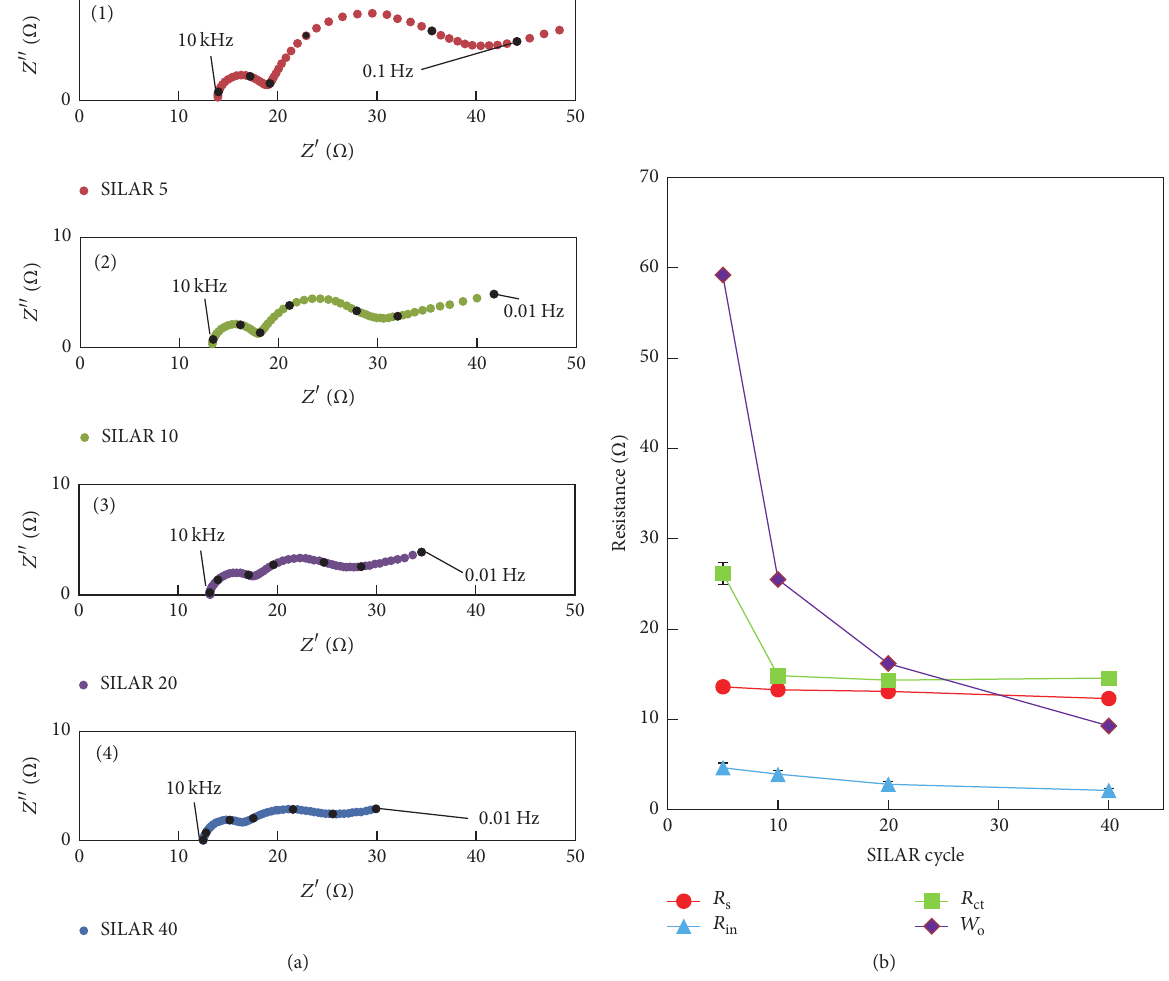
Figure 4: Nyquist plots of porous-FTO (5 𝜇 m)/CuS electrodes for various SILAR cycles. Panels (a)(1), (a)(2), (a)(3), and (a)(4) are the results for SILAR cycles with 5, 10, 20, and 40 times, respectively. SILAR cycles dependence on the resistance is shown in panel (b). Black dots in panels (a)(1) to (a)(4) indicate the data recorded under each decade of the